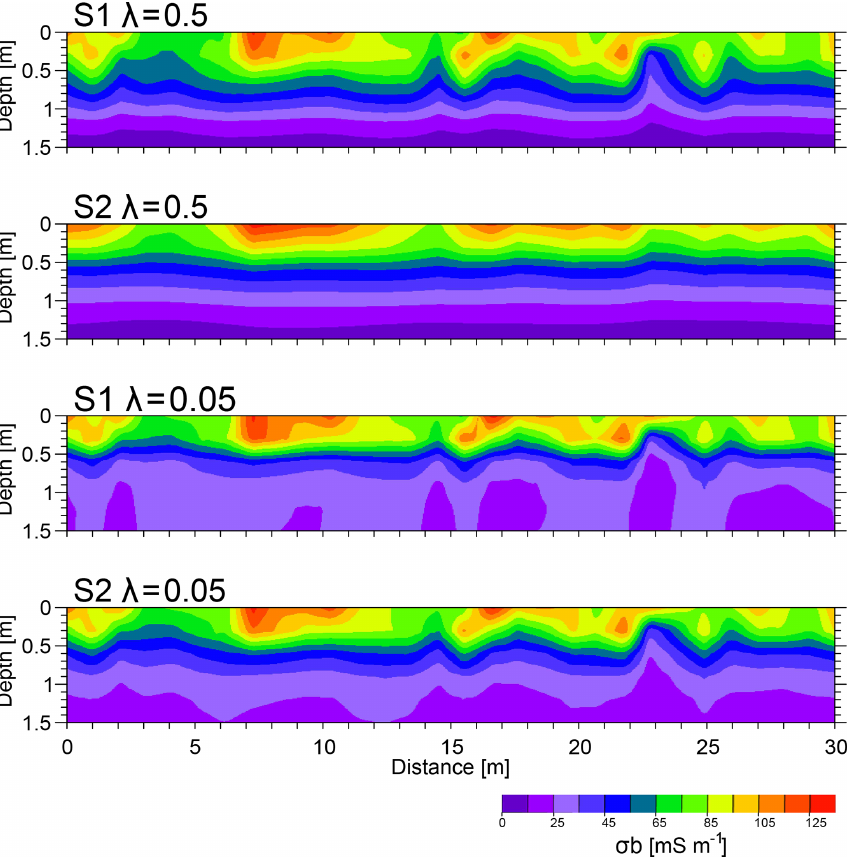
Figure 10. σ b distributions obtained from the inversion of the synthetic σ a data (23 November), shown in Fig. 9, using four different combinations of two algorithms, S1 and S2, and λ